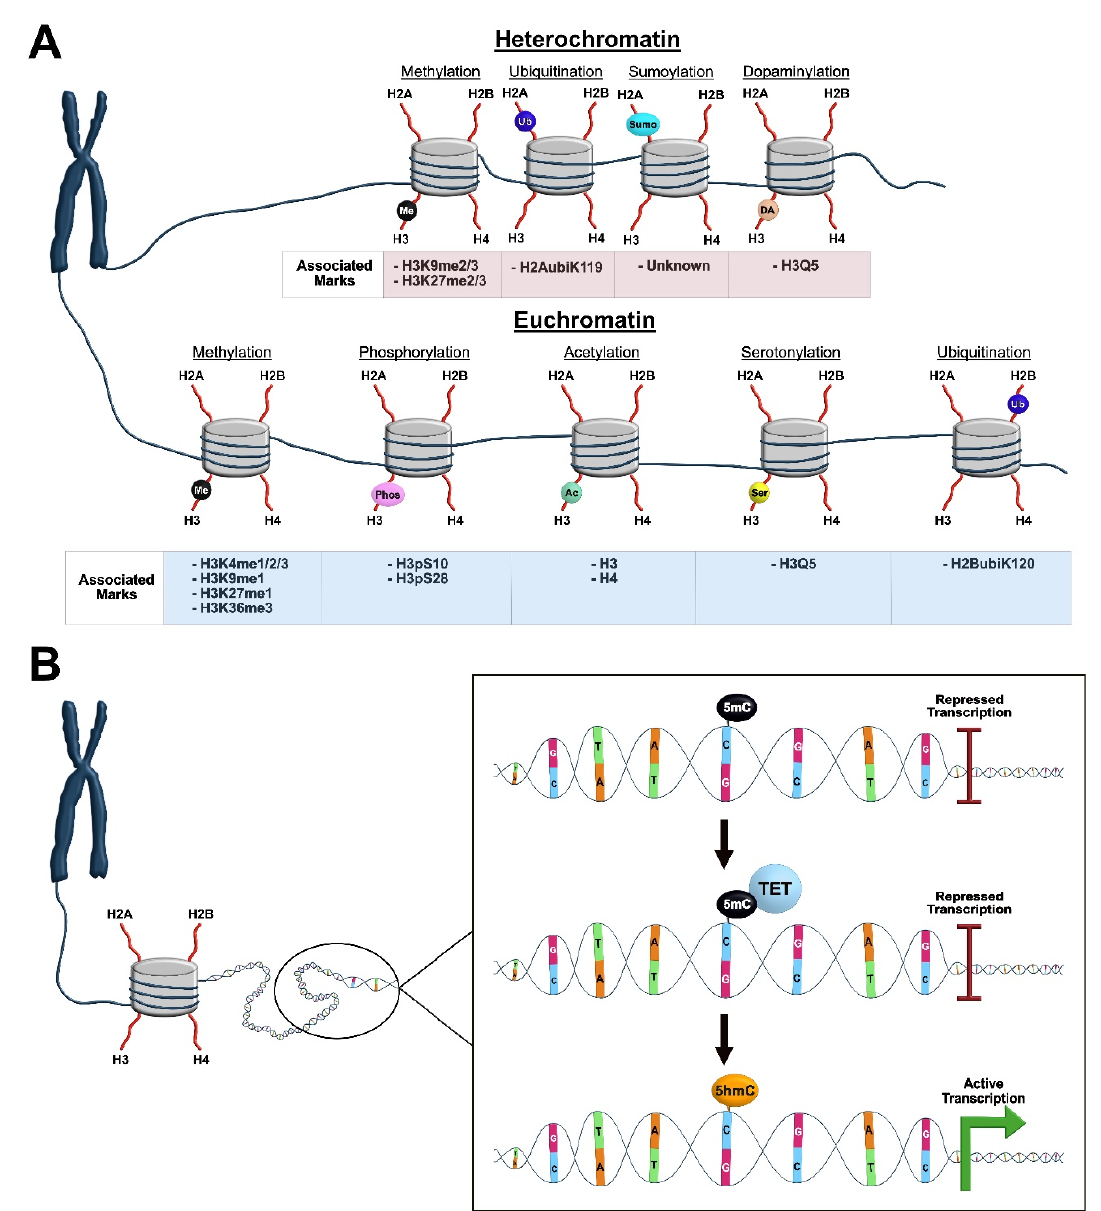
Figure 1. Overview of epigenetic mechanisms. DNA is packaged into the chromosome as chromatin which is wrapped around the nucleosome structure containing two copies each of the core histone proteins (H2A, H2B, H3, and H4) with protruding N-terminal tails. ( A ) Several post-translational modifications (PTMs) can occur at histone proteins to regulate chromatin structure and gene transcription. Epigenetic PTMs of histones associated with a heterochromatin state (top) include methylation (black), ubiquitination (purple), sumoylation (aqua), and dopaminylation (orange). Specific histone modification sites associated with heterochromatin state for each group of PTMs are described as associated marks (red box). Epigenetic PTMs of histones associated with a euchromatin state (bottom) include methylation (black), phosphorylation (pink), acetylation (green), serotonylation (yellow), and ubiquitination (purple). Specific histone modification sites associated with euchromatin state for each group of PTMs are described as associated marks (blue box). ( B ) DNA methylation is an epigenetic mechanism that can be associated with either active or repressed transcription. The circle indicates a portion of DNA that is magnified within the black outlined box (right). The 5mC mark (black) is established on a cytosine residue and is associated with transcriptional repression. The TET enzymes (blue) are recruited to the 5mC mark to initiate the demethylation process. The 5mC mark (black) is converted to the 5hmC mark (orange), which is associated with active gene transcription. Nucleotides are illustrated as follows: Thymine (T; green), Adenine (A; orange), Guanine (G; pink), Cytosine (C;